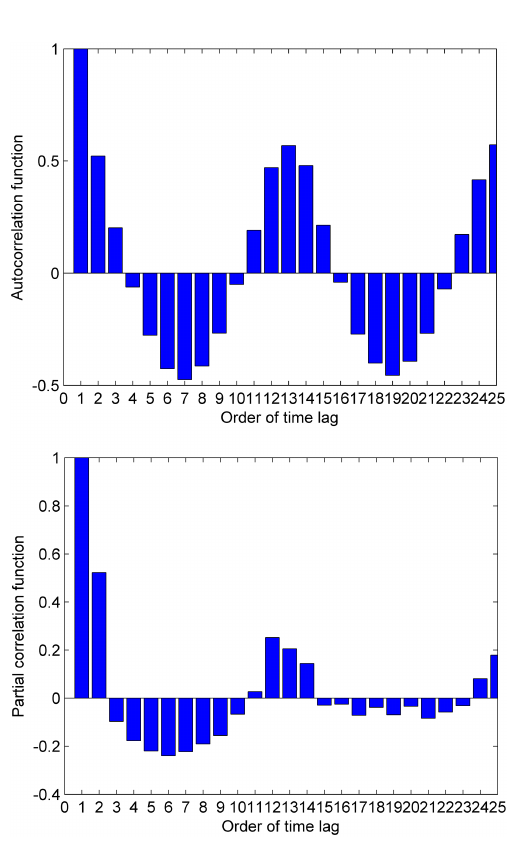
Figure 5. Autocorrelation and partial correlation plots of data series after differencing. Upper panel: autocorrelation; lower panel: partial